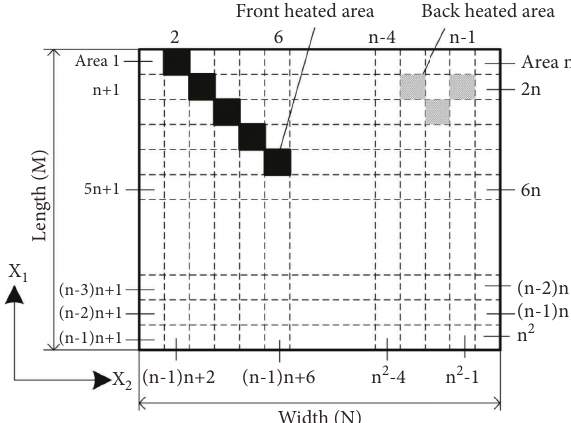
Figure 3: Discretization of area position using a uniform finite pixel meshing.